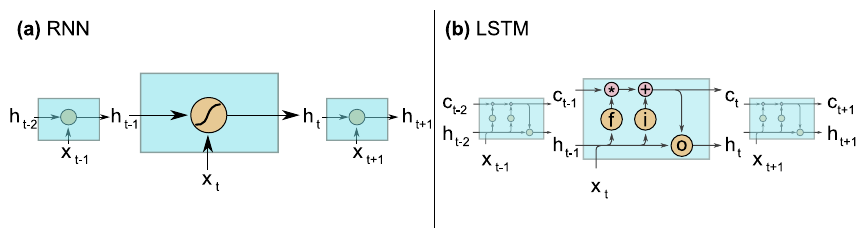
Figure 2. (a) The internal operation of a traditional RNN cell: h t stands for hidden state and x t for the input at time step t . (b) The internals of a LSTM cell, where f stands for the forget gate (Eq. 2), i for the input gate (Eqs. 3–4), and o for the output gate (Eqs. 6–7). c t denotes the cell state at time step t and h t the hidden